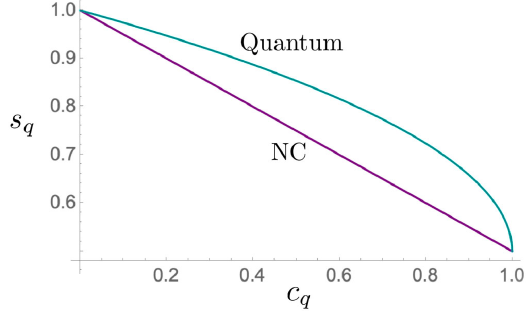
FIG. 2. Optimal trade-off for a noncontextual (NC) model (purple line) and for quantum theory (light blue